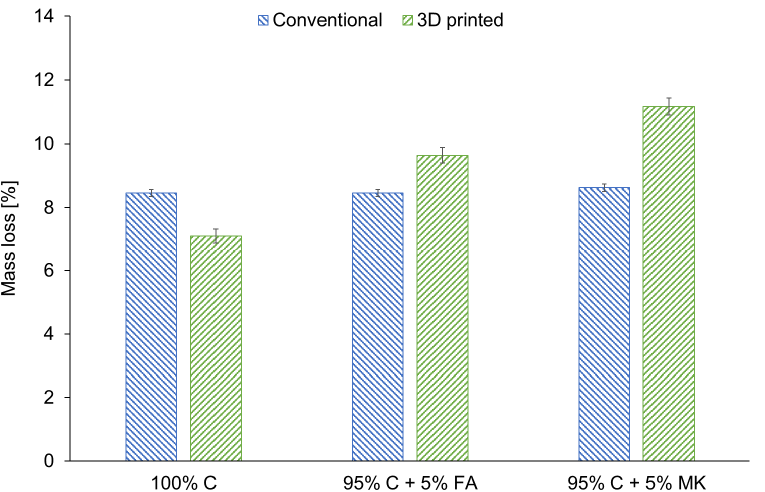
Figure 6. The mass loss after fire-resistance tests for concrete (100% C) and concrete-geopolymer hybrids based on fly ash (95% C + 5% FA) and metakaolin (95% C + 5% MK) that were cast and 3D printed.